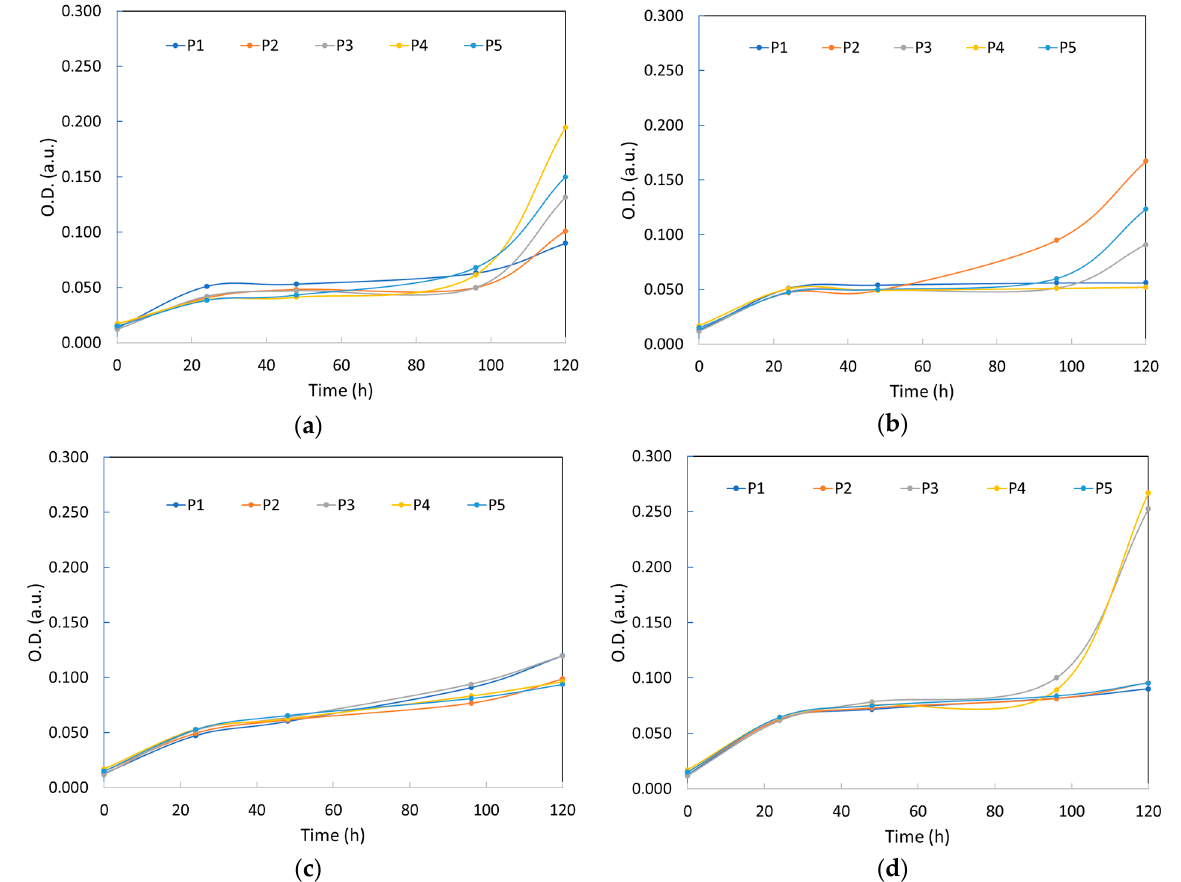
Figure 3. Growth curve of yeast strains under experimental conditions: ( a ) in synthetic wastewater; ( b ) synthetic wastewater contaminated with Pb 2+ ; ( c ) synthetic wastewater contaminated with Cd 2+ ions; ( d ) synthetic wastewater contaminated with Pb 2+ and Cd 2+ .